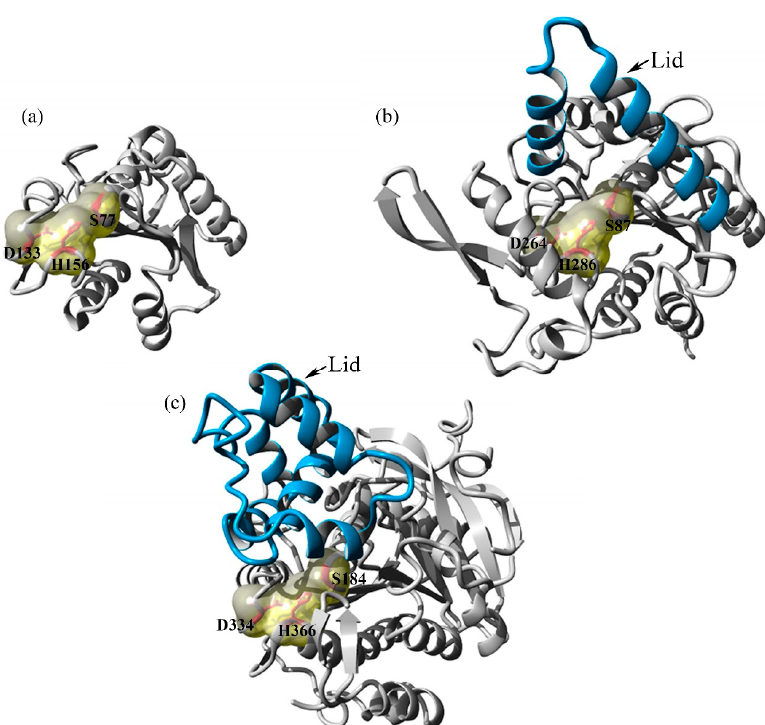
Figure 1. Three types of lipase’s lids with the position of catalytic triads residues shown. ( a ) Bacillus subtilis lipase, with no lid domain (PDB: 1I6W) [57]; ( b ) Burkholderia cepacia lipase, with a loop of the lid (PDB: 3LIP) [58]; ( c ) Candida antarctica A lipase, with multiple helices of the lid (PDB: 2VEO) [59]. Catalytic triad residues were highlighted by red residues and yellow surface and lid domains were highlighted by blue color. (Figures prepared by